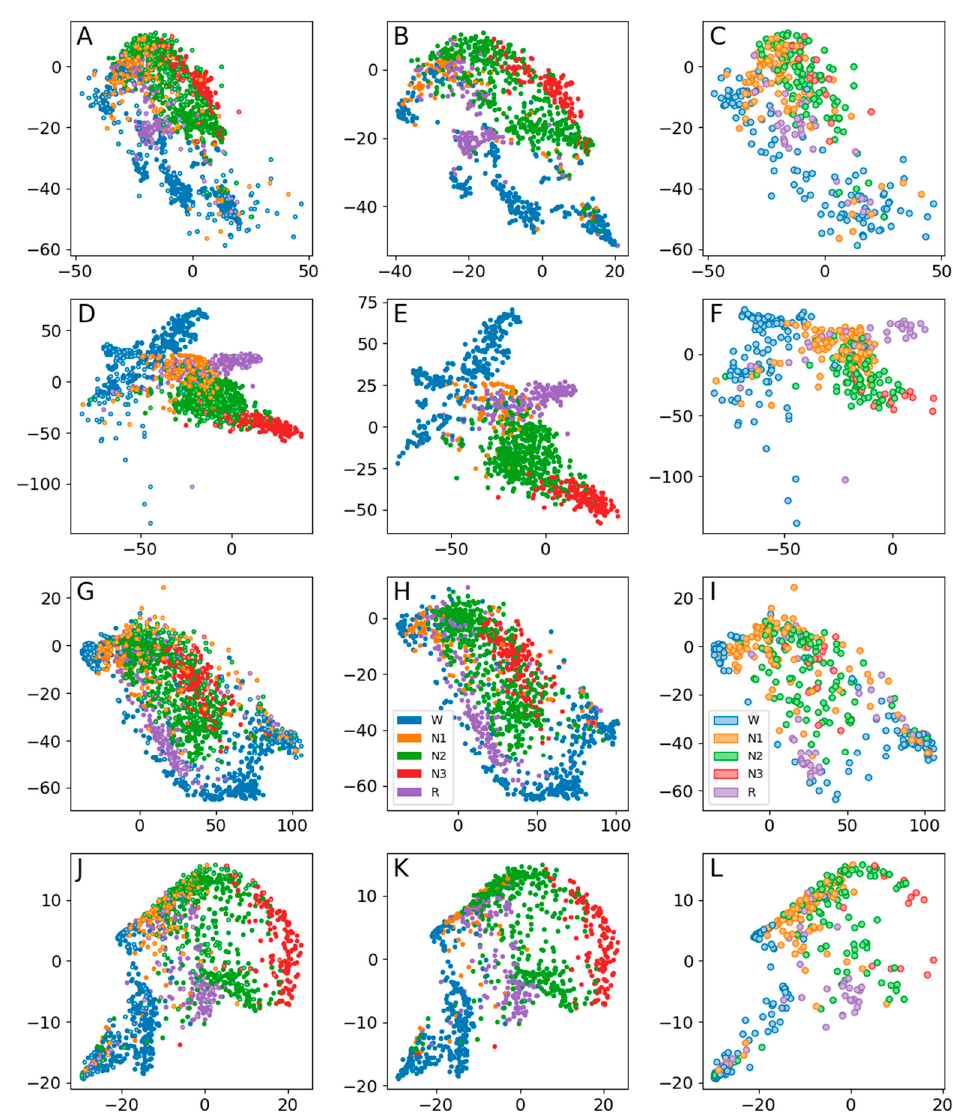
Figure A16. Low-dimensional representations of the 12-h dataset. Each dot represents 30 s of data. Blue = awake; orange = sleep stage N1; green: sleep stage N2; red: sleep stage N3; purple: REM. First row ( A – C ): CNN encoder. Second row ( D – F ): STFT encoder. Third row ( G – I ): CWT encoder. Fourth row ( J – L ): CNN encoder using overlapping examples. First column ( A , D , G , J ): all data. Second column ( B , E , H , K ): training data. Third column ( C , F , I , L ): test